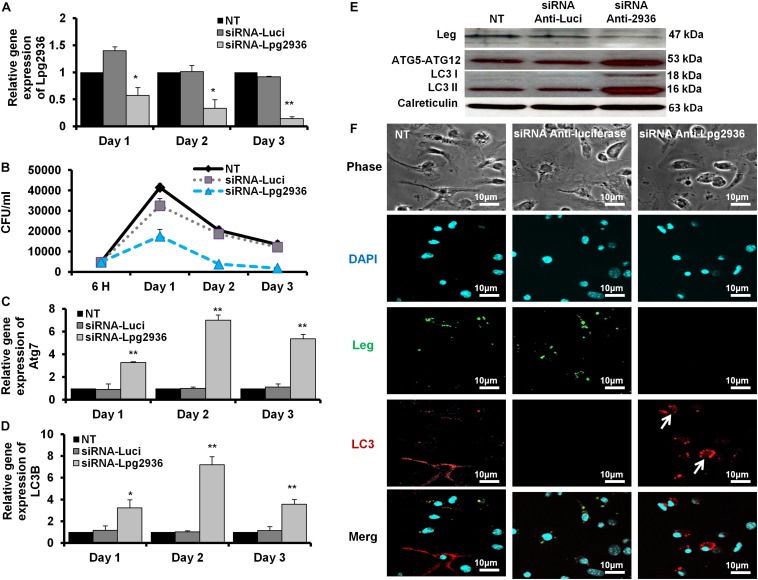
Autophagosome formation and bacterial replication in Lpg2936-knockdown cells. (A) Quantification of Lpg2936 steady-state mRNA in mice-derived macrophages that represented the knockdown efficiency during indicated time points following infection in comparison with control transfection (siRNA-Luci) using qRT-PCR test. (B) Colony-forming unit (CFU) assay of Legionella replication in siRNA-Lpg2936 transfected macrophages during the indicated time points post-infection compared to control-transfected and non-transfected cells. (C,D) Relative expression of autophagy-related genes Atg7 and LC3B in siRNA-transfected and -infected macrophages during the indicated time points using qRT-PCR. (E) Immunoblotting assays represent Legionella indicator protein, Atg5–Atg12 protein complex, LC3-I, and LC3-II in siRNA-transfected and -infected macrophages. Calreticulin served as an internal control. (F) Immunofluorescent assay represents accumulated LC3B puncta (red) and Legionella protein biomarker (green) in murine-derived macrophages in response to siRNA transfection-induced Lpg2936 knockdown. DAPI was used for chromosome counterstaining (blue). Error bars reveal the SD of three independent experiments. Student two-tailed t test was used for statistical differences of Ct values in different groups. ∗P ≤ 0.05 and ∗∗P ≤ 0.01.